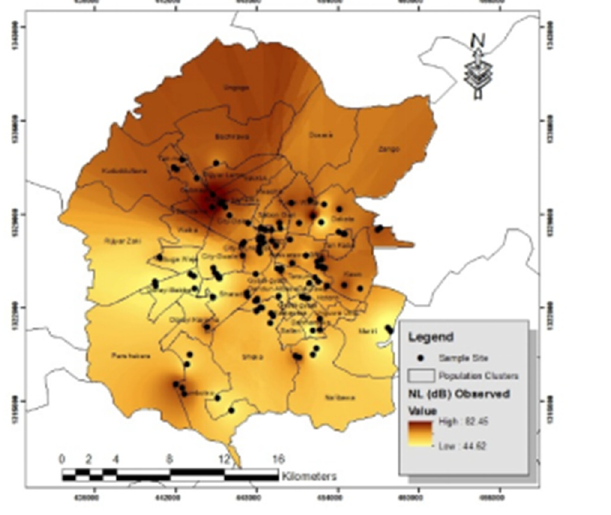
( b ) Figure 2. ( a ) Normality of observed noise level and ( b ) normality of predicted noise level. 4. Discussion The mean levels in all locations were above the permissible limit. This finding agrees with [19], [6] that reported higher noise above the recommended levels in two Nigerian cities. As expected, that higher population is in congruence with higher noise pollution [37]. Noise is governed by several factors. Among the factors are population [38], land use